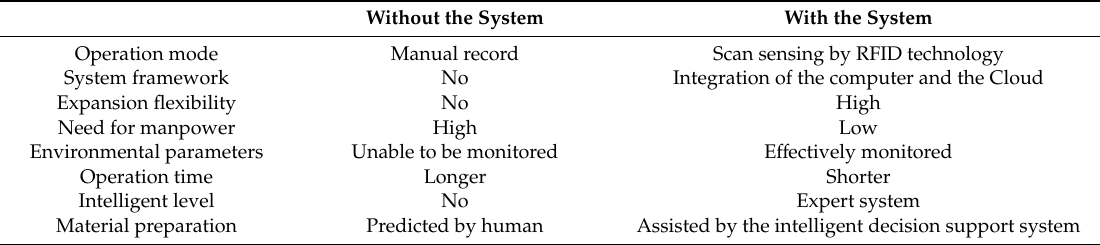
Table 5. Comparison of with and without system